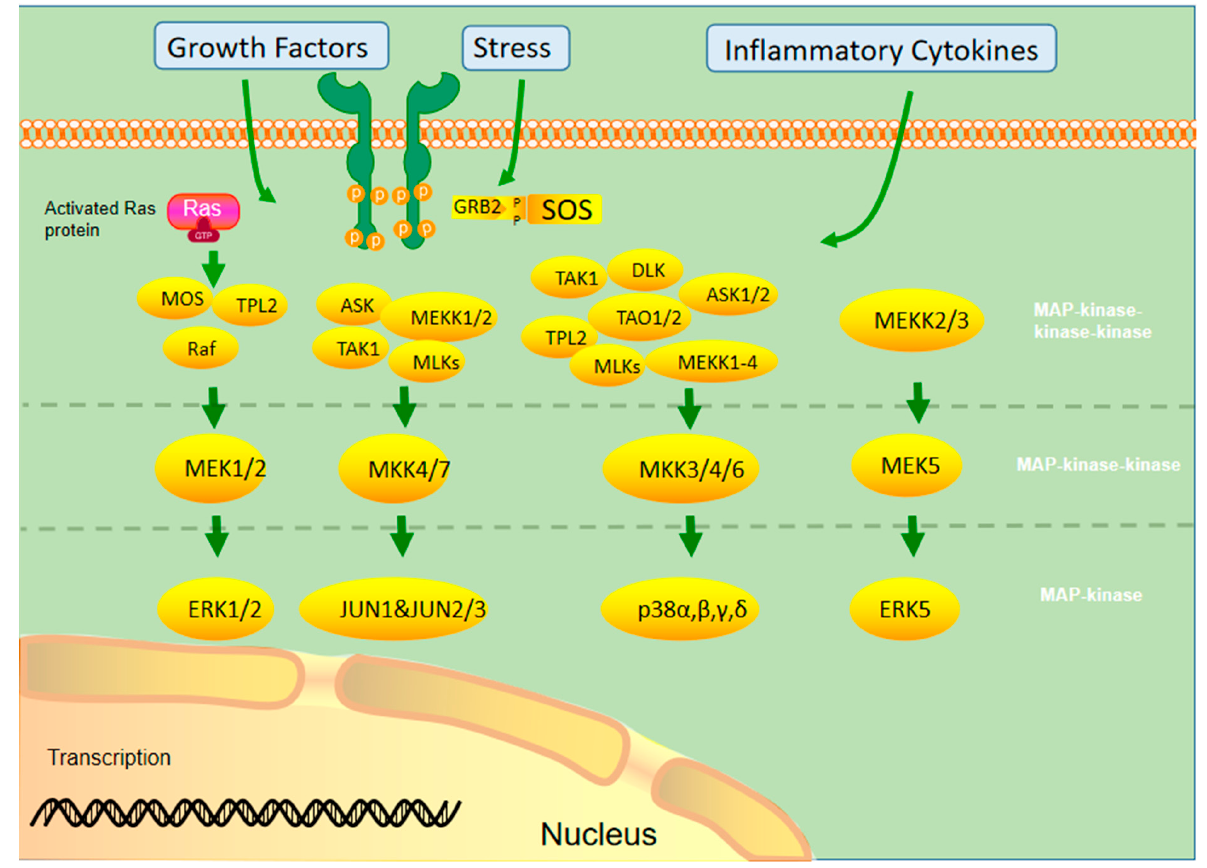
Figure 1. Different MAPKs associate with specific MAPK kinase (MAPKK) and MAPK kinase kinase (MAPKKK) to form a conserved three-stage enzymatic cascade (MAPKKK → MAPKK → MAPK), through which upstream signals are transmitted from MAPK to downstream nuclear transcription factors and cytoskeletal proteins to form a complete MAPK signaling pathway, which finally completes the regulation of cellular physiological activities.